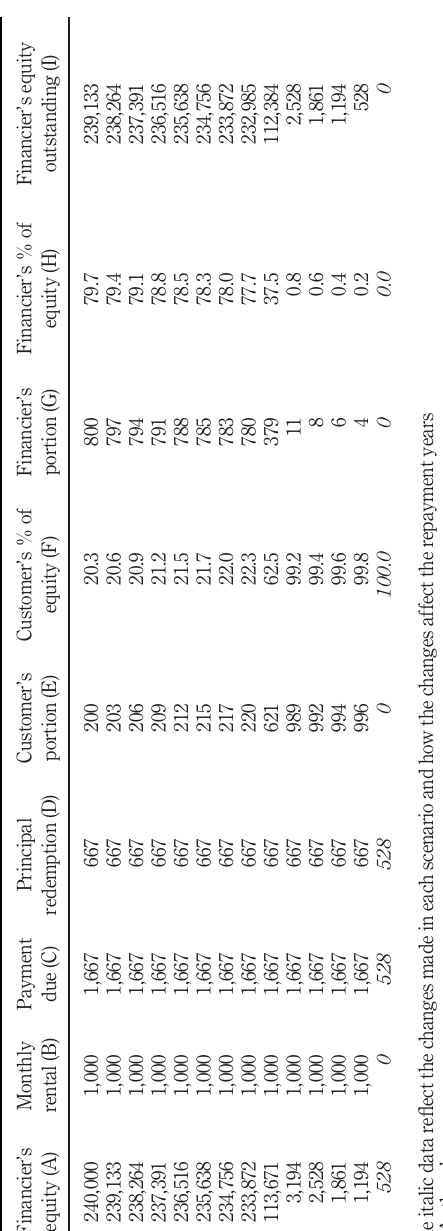
Table II. Reinvestment of periodic